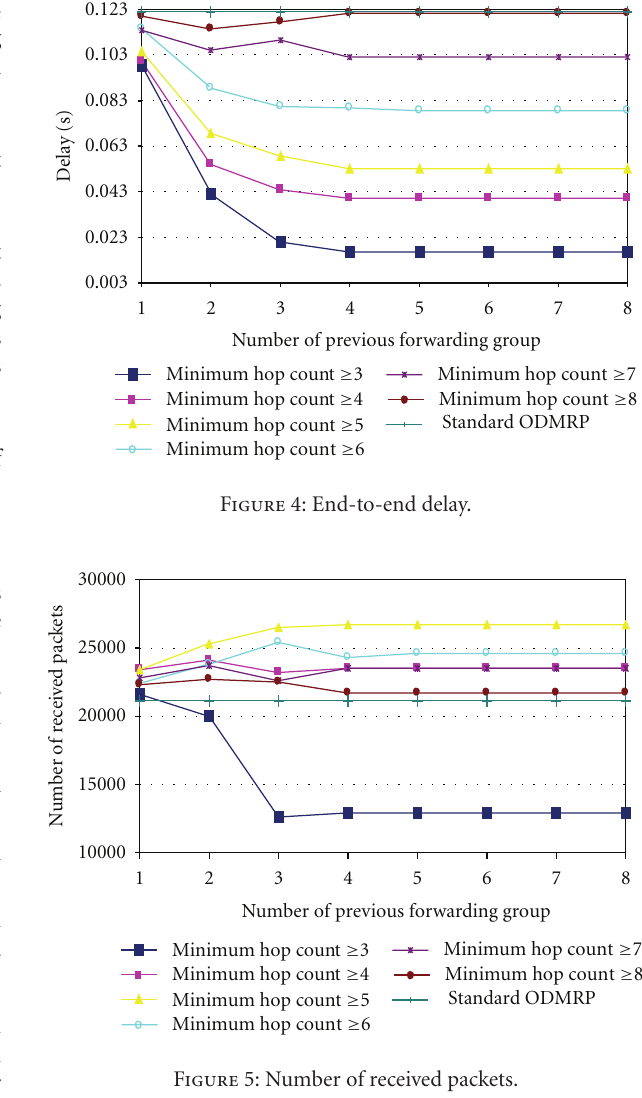
Figure 5: Number of received